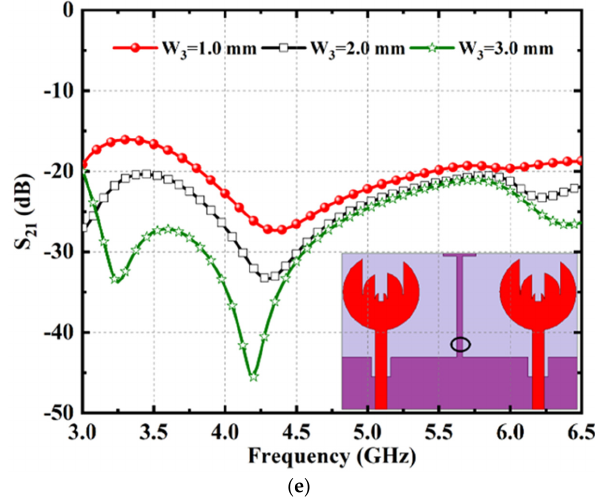
Figure 4. Two–element MIMO antenna parametric analysis S–parameters response; ( a ) Lg; ( b ) Wf; ( c ) L1; ( d ) W3; and ( e ) W3 for isolation.